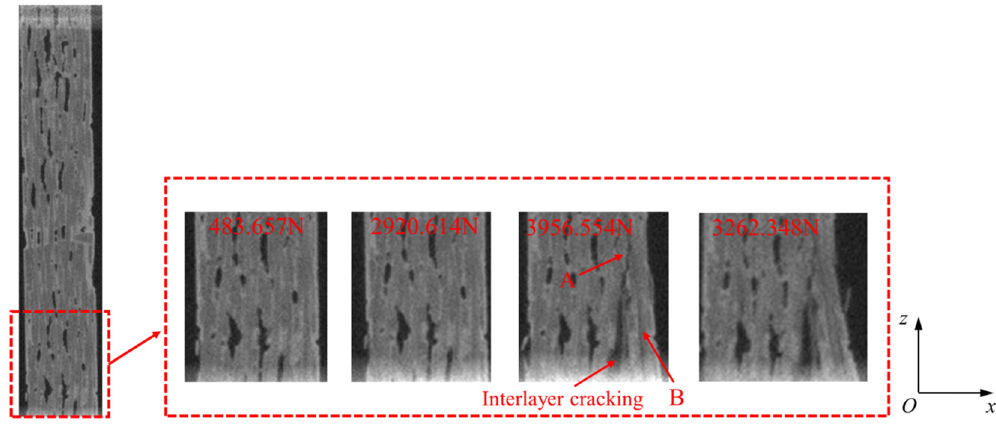
Figure 7: Damage evolution process of local area on ZOX cross -